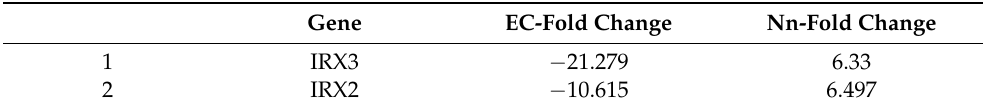
Table 5. Genes in transcription factor category that are downregulated in endothelial cells and upregulated in neural